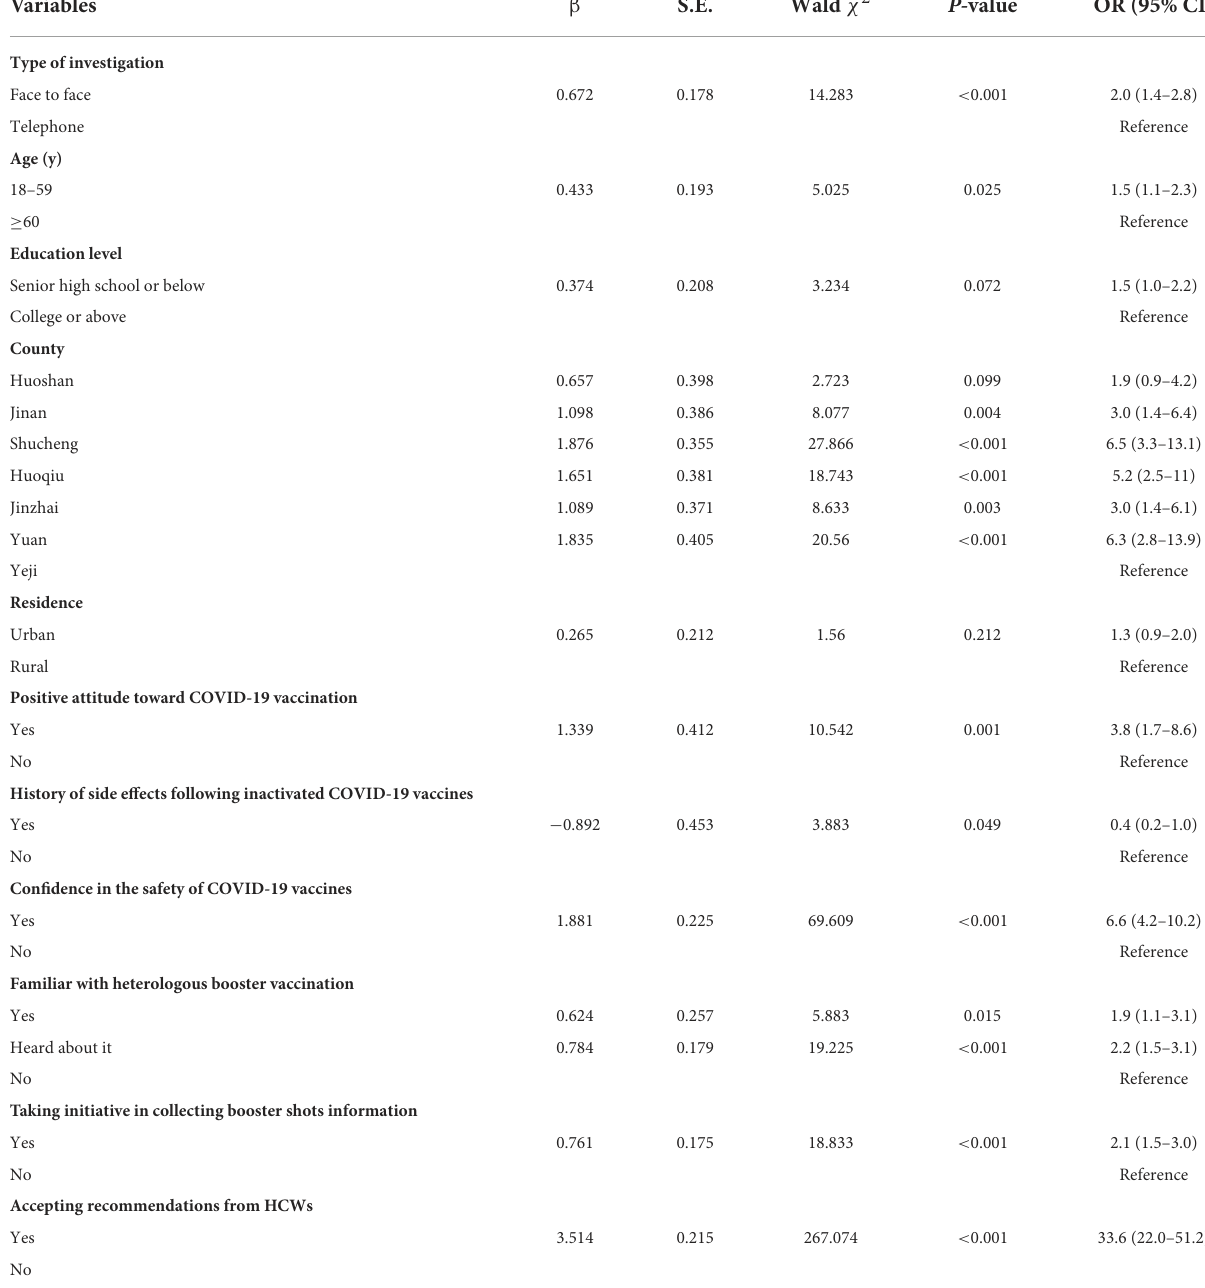
TABLE 3 Multiple logistic regression of factors associated with willingness to accept the heterologous booster